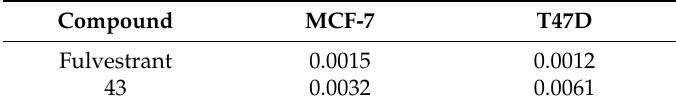
Table 4. E ff ects on growth inhibition (IC 50 , µ M ) of fulvestrant and compound 43 in di ff erent breast cancer cell